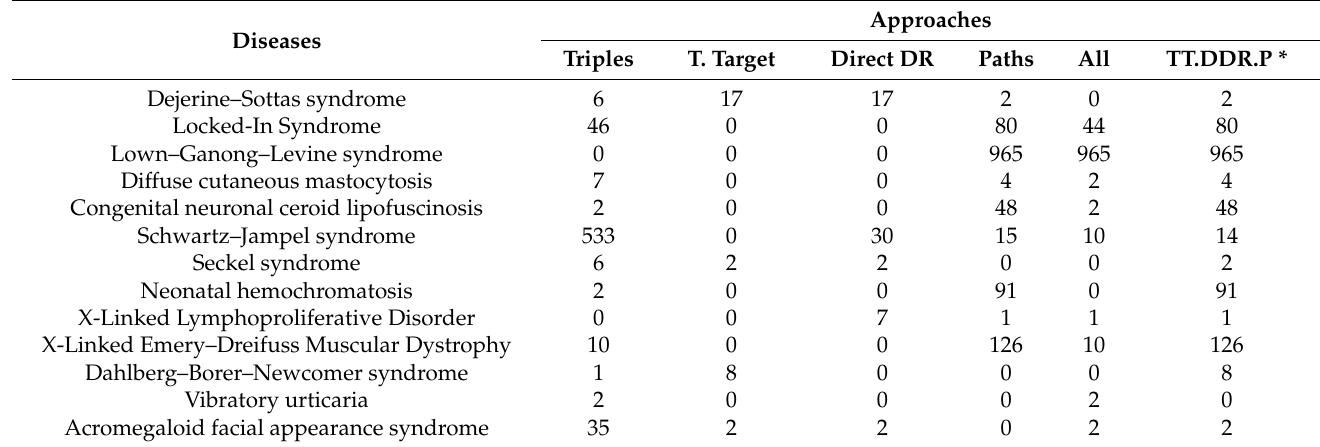
Table 2. The four computational drug-repositioning approaches developed are summarized here. Each case’s number in the table represents the number of drugs